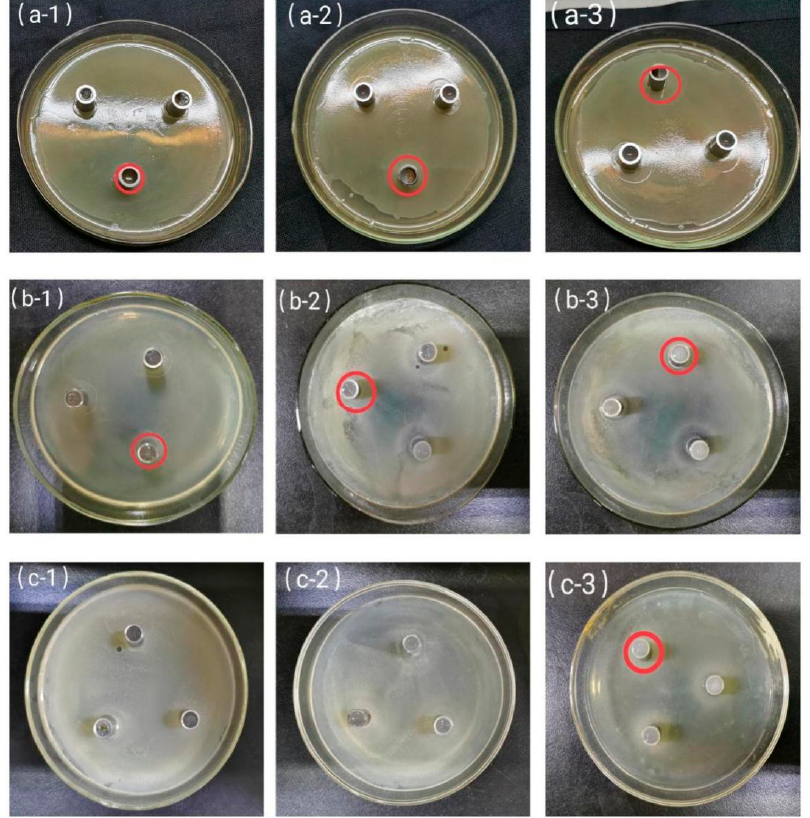
Figure 5. Oxford cup test (1) CTS; (2) CTS-TiO 2 ; (3) CTS-TiO 2 -Ag. Composite material pair: ( a ) Escherichia coli; ( b ) Staphylococcus aureus; ( c ) Antibacterial property of bacillus subtilis. Table 1. Inhibition zone size of CTS, CTS-TiO 2 and CTS-TiO 2 -Ag after treatment. Treatment